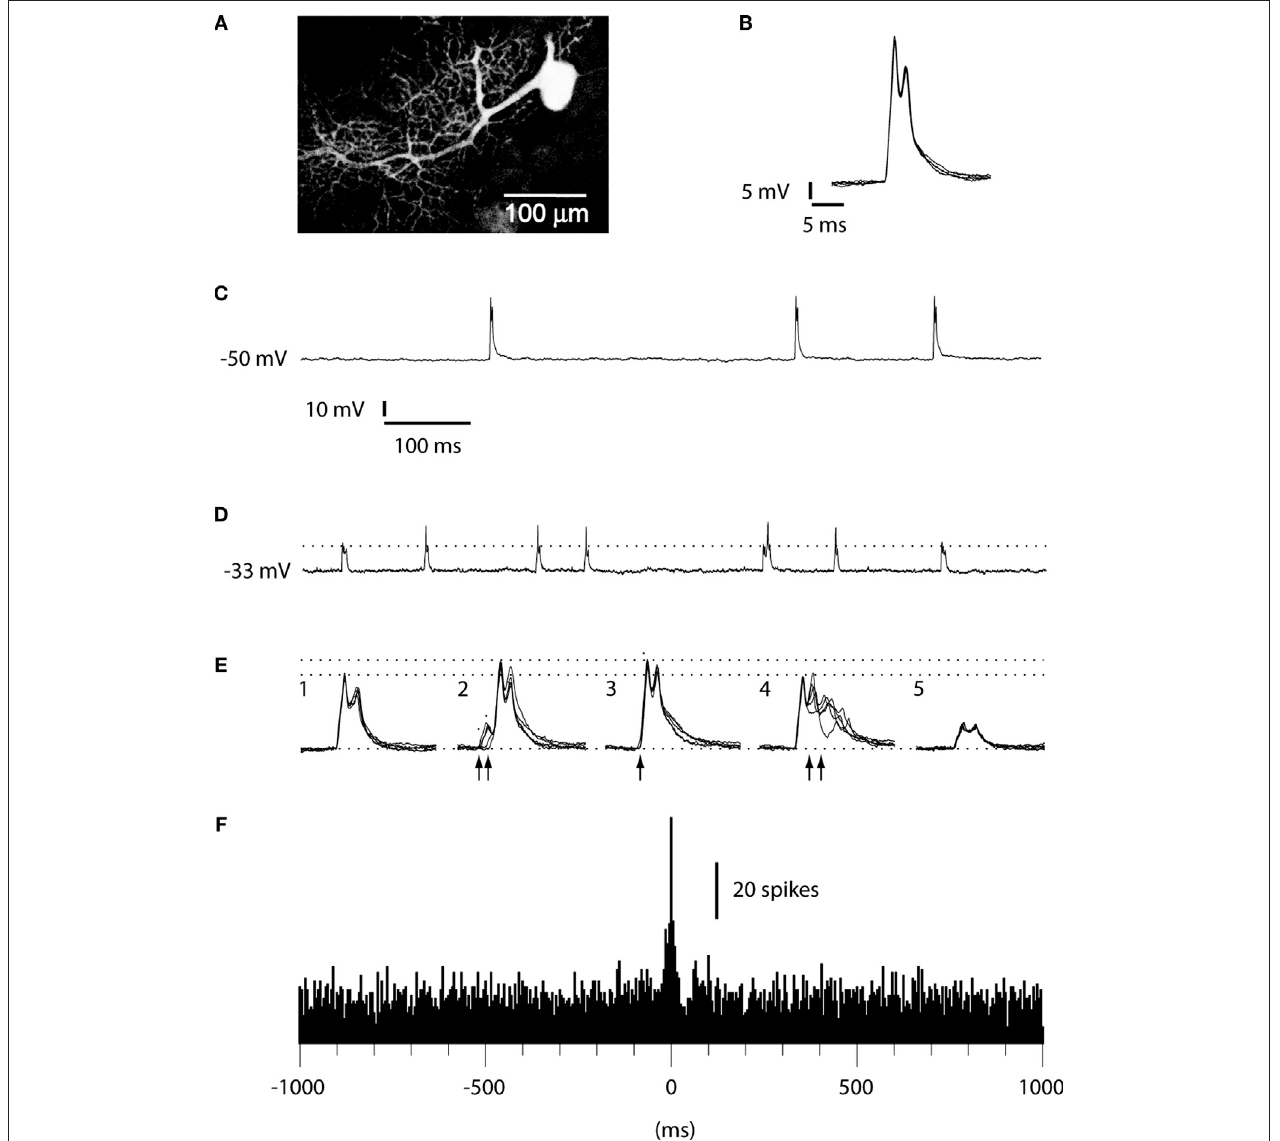
the peak amplitudes of the largest unit in isolation and during coincident activation with the smaller unit, respectively. (E1 and E5) Superimposed spikes of the two dendritic spike units in isolation. (E2) Recorded response when the onset of the small unit (arrows) barely preceded the large unit. (E3) Recorded response when the small and large units coincided in time. (E4) Recorded response when the small unit was activated after the larger unit. (F) Histogram of cross-correlated activity with the spike times of the larger unit serving as the ‘trigger’ against which the relative spike times of the smaller unit were plotted. Bin width: 5